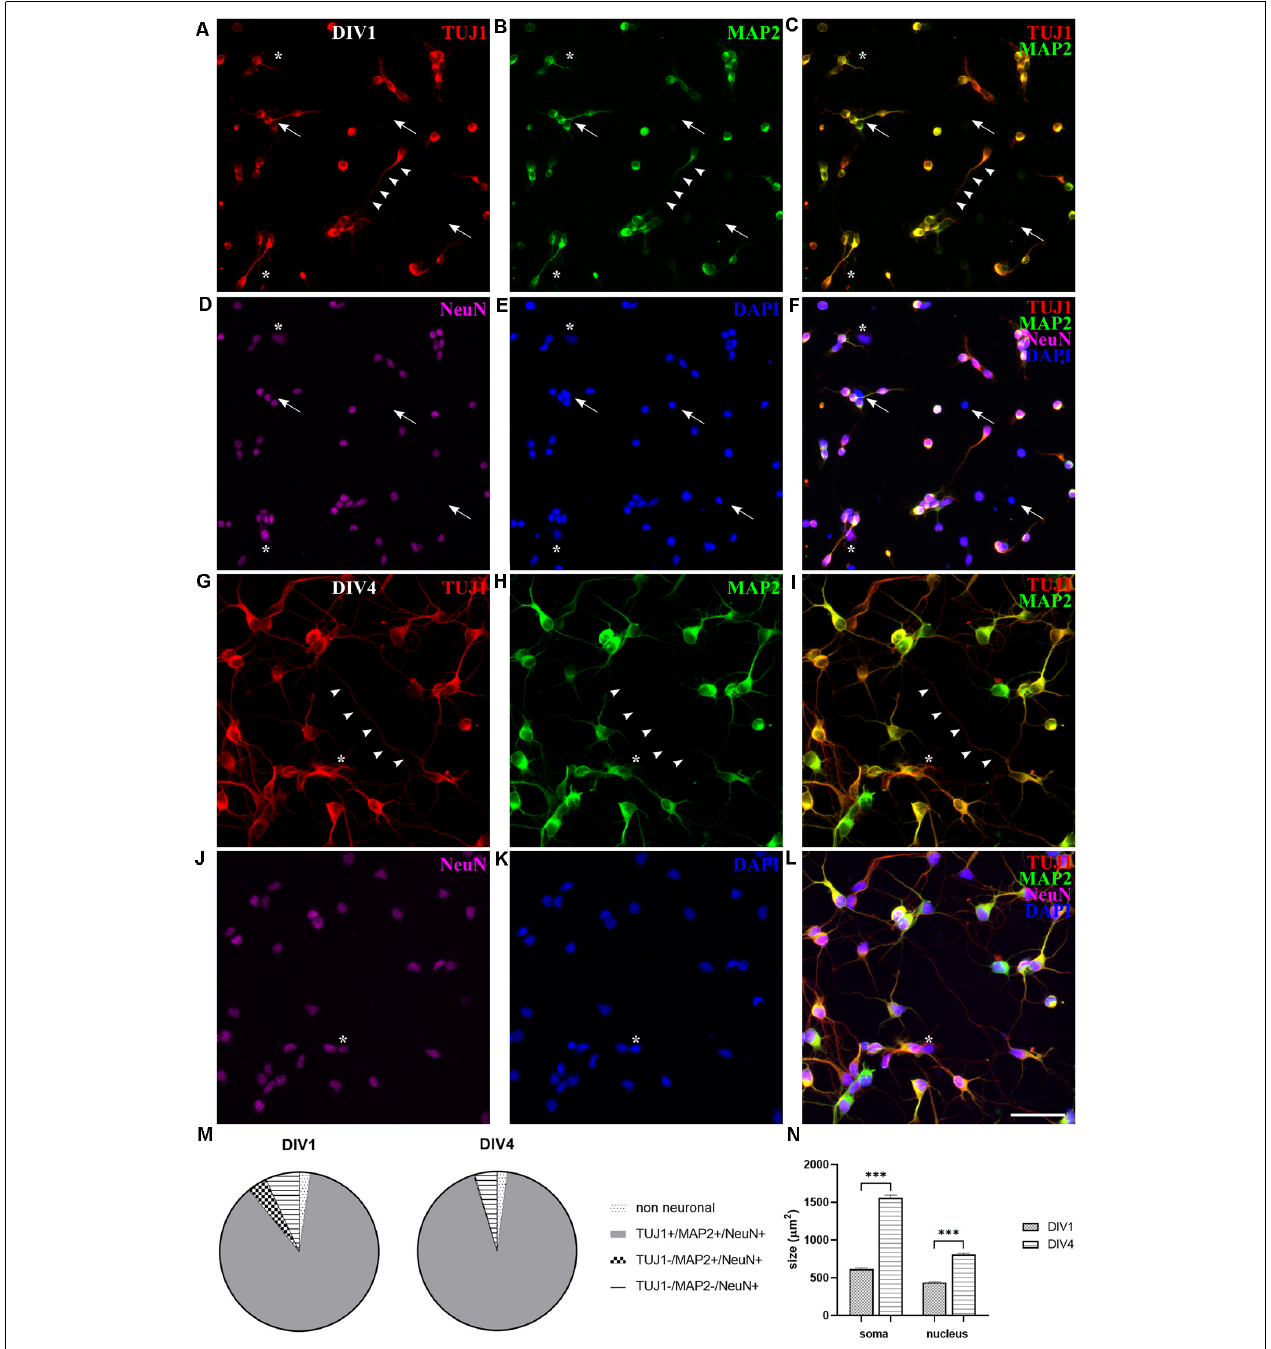
FIGURE 2 | Expression of neuronal markers in cortical cultures derived from P5 opossum. Cells were fixed at DIV1 and stained for (A) TUJ1 (red), (B) MAP2 (green), (D) NeuN (magenta), and (E) DAPI nuclear stain (blue). (C) Merged image of TUJ1 and MAP2. (F) Merged image of all markers. (G–L) Same as (A–F) but for DIV4 cultures. Asterisks indicate TUJ1 − /MAP2 − /NeuN + and arrows indicate non-neuronal (TUJ1 − /MAP2 − /NeuN − ) cells. Arrowheads indicate TUJ1 + /MAP2 − axon. (M) Percentage of expression for TUJ1, MAP2, and NeuN at DIV1 and DIV4, respectively. (N) Neuronal cell bodies (soma) and neuronal nuclei size increased from DIV1 to DIV4. Unpaired t-test with Welch’s correction. DIV1 soma vs. DIV4 soma p < 0.001 ∗∗∗ , DIV1 nucleus vs. DIV4 nucleus p < 0.001 ∗∗∗ . Scale bar, 50 µ m.